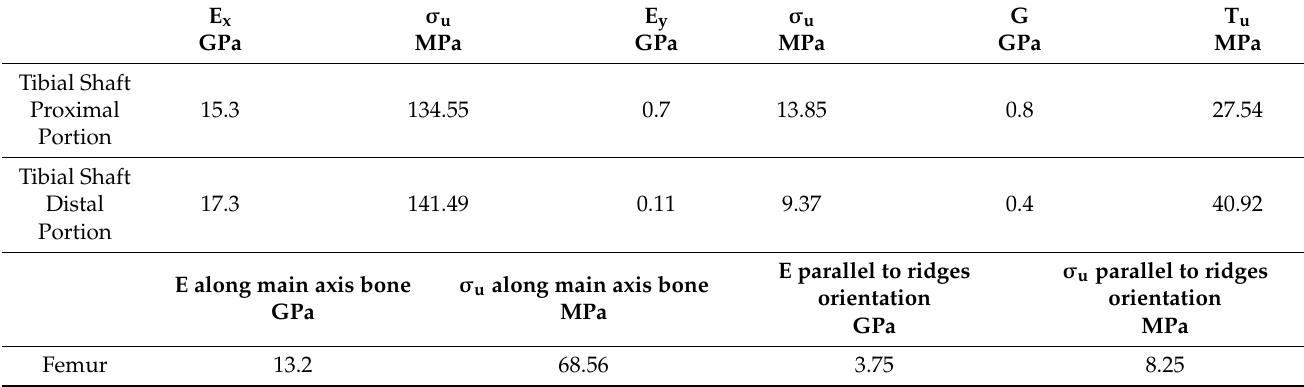
Table 1. Table illustrating the results of the tests conducted on ostrich limb